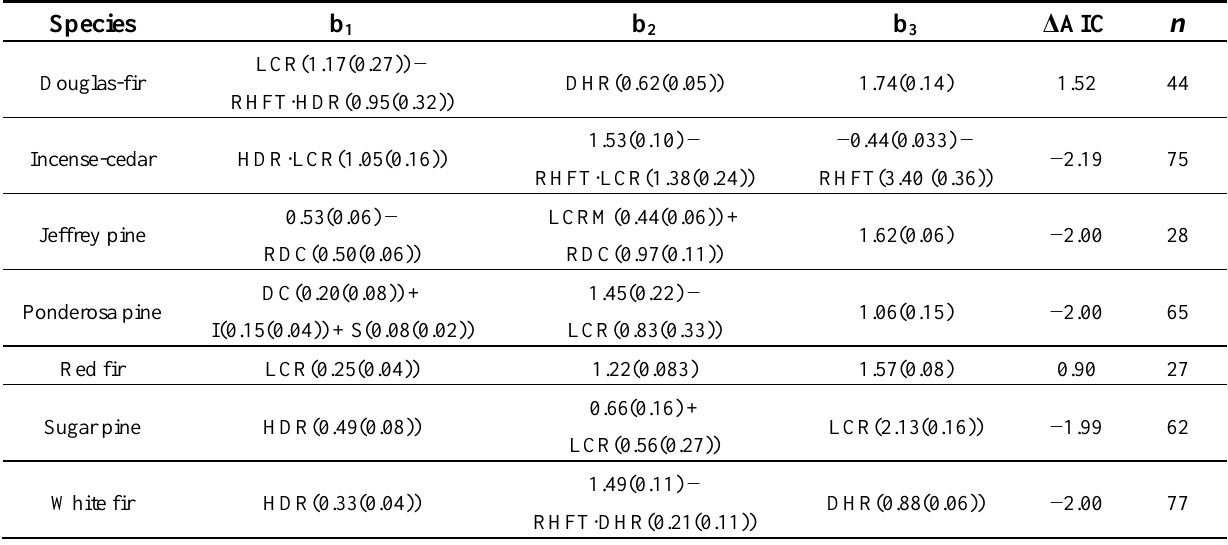
Table 5. Summary of model parameter estimates for branch leaf area by species.